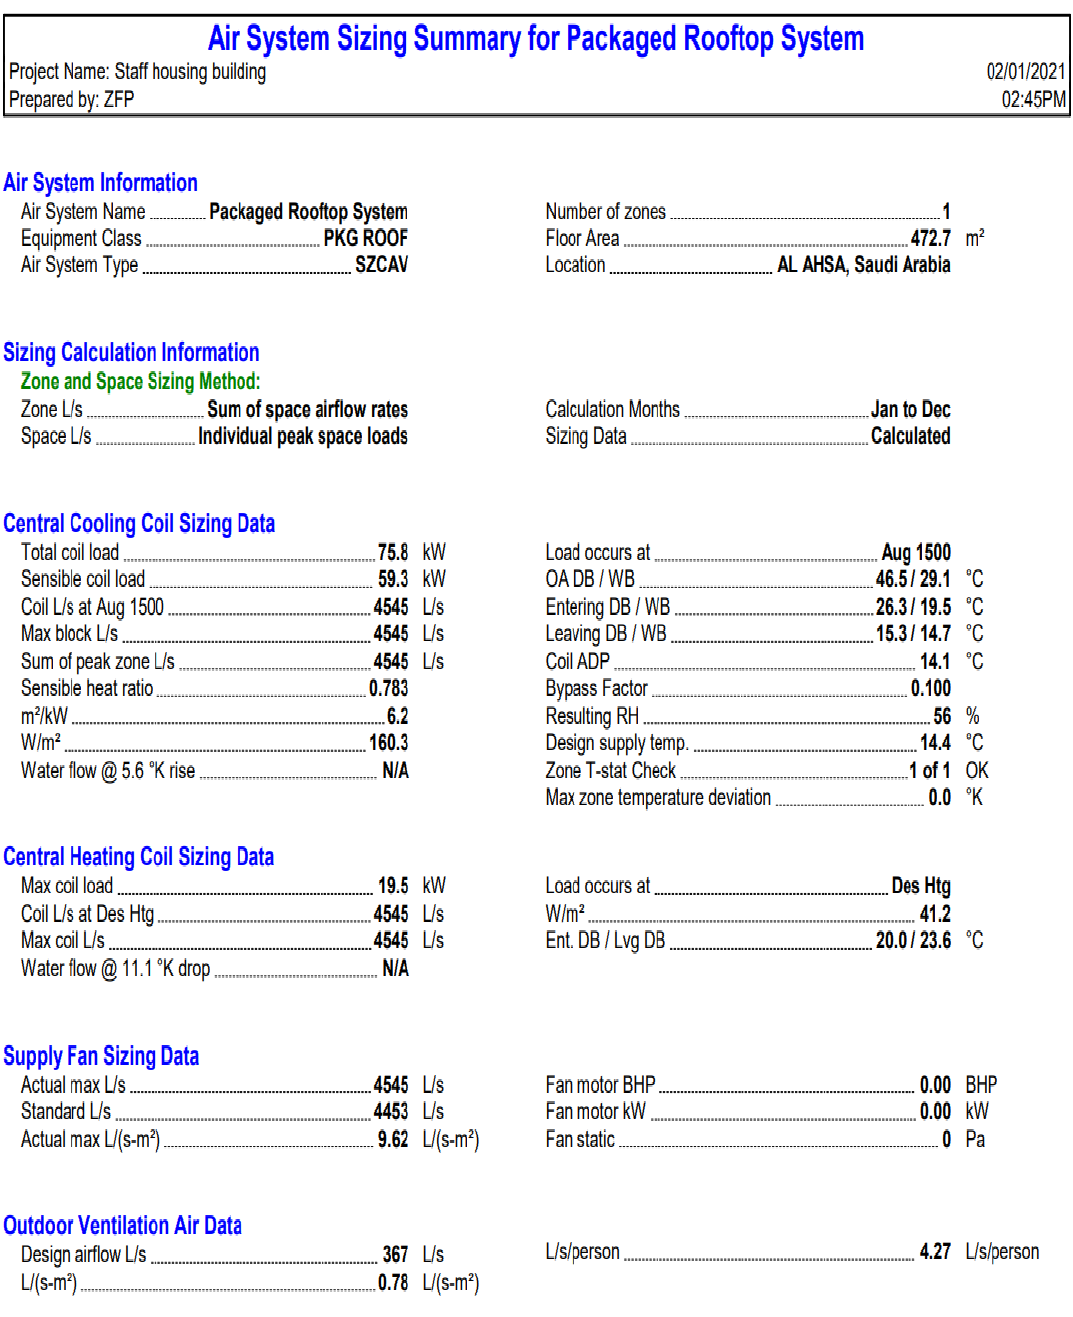
Figure A6. Packaged A/C units cooling load calculations.